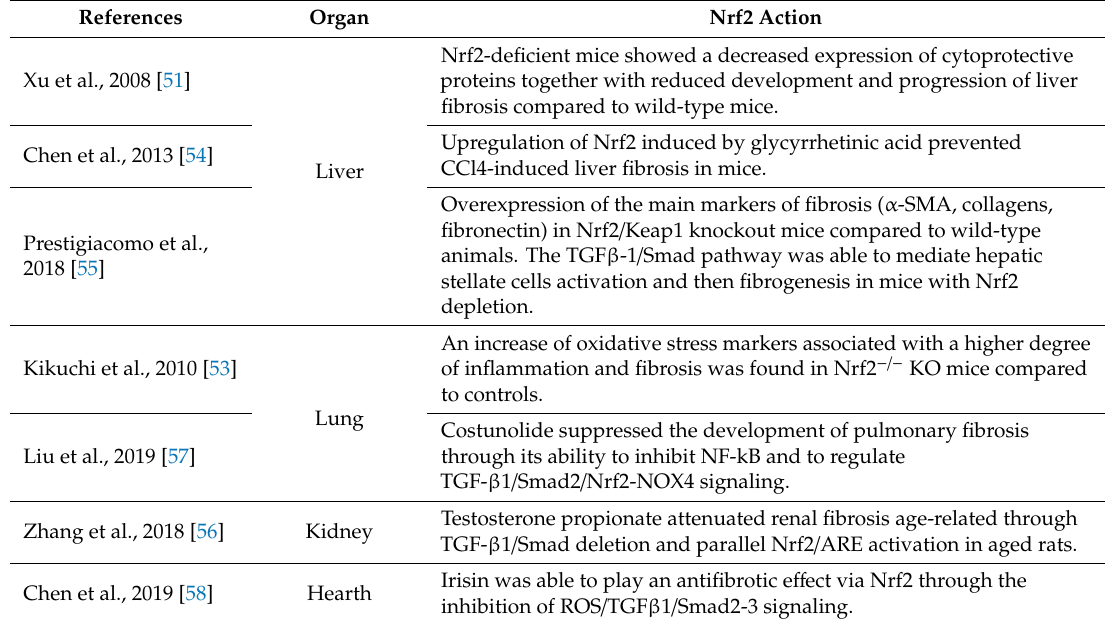
Table 1. Studies assessing Nrf2 involvement in inflammation and fibrosis in various